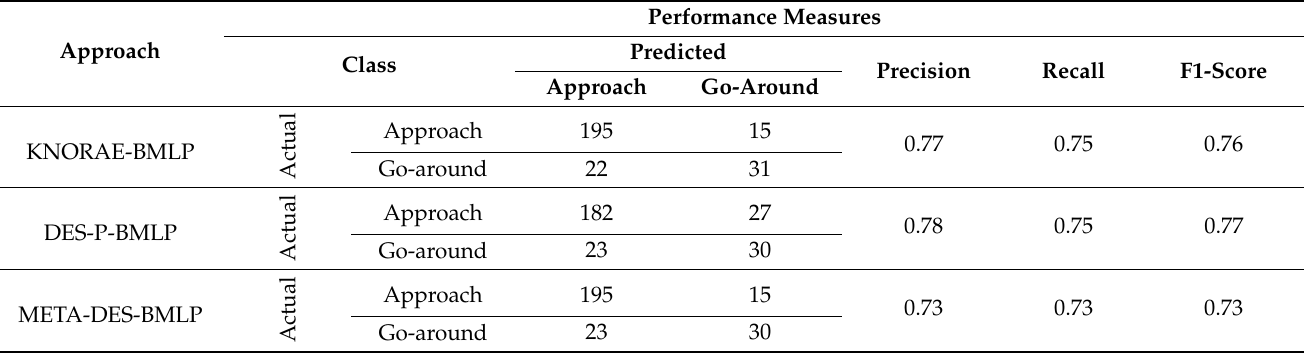
Table 8. Comparison of performance measures of DES based on the pool of BMLP.